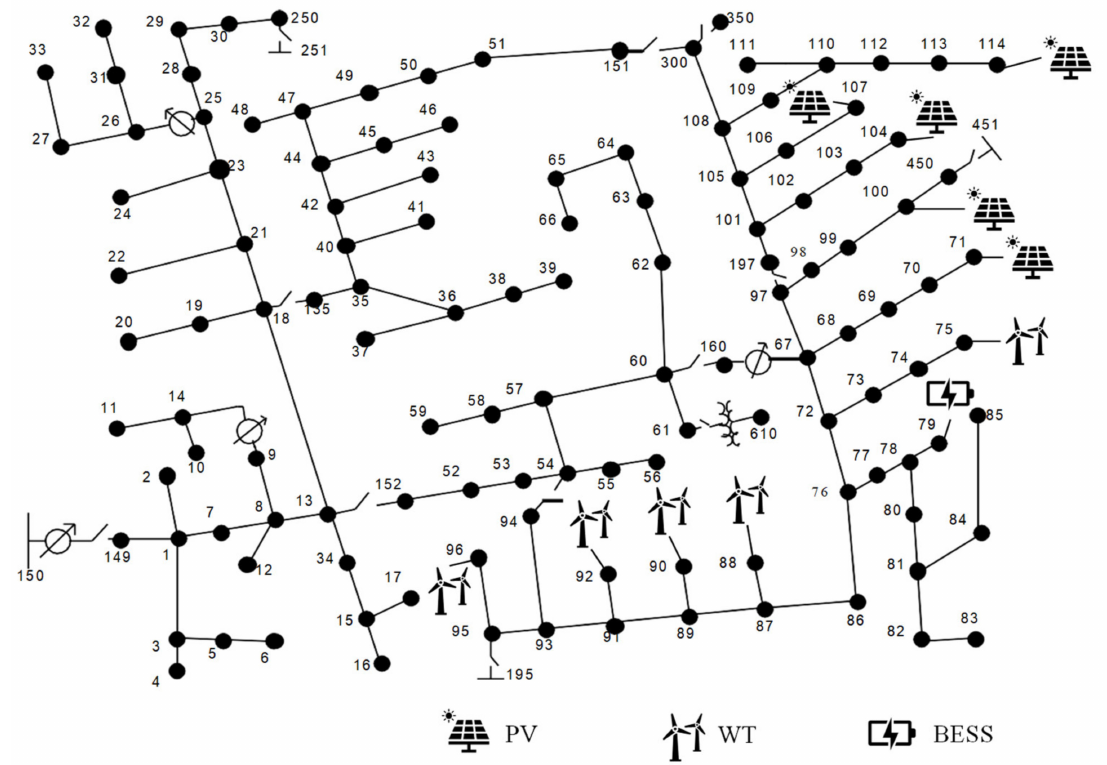
Figure 1. The topological diagram for the modified IEEE 123 bus system.